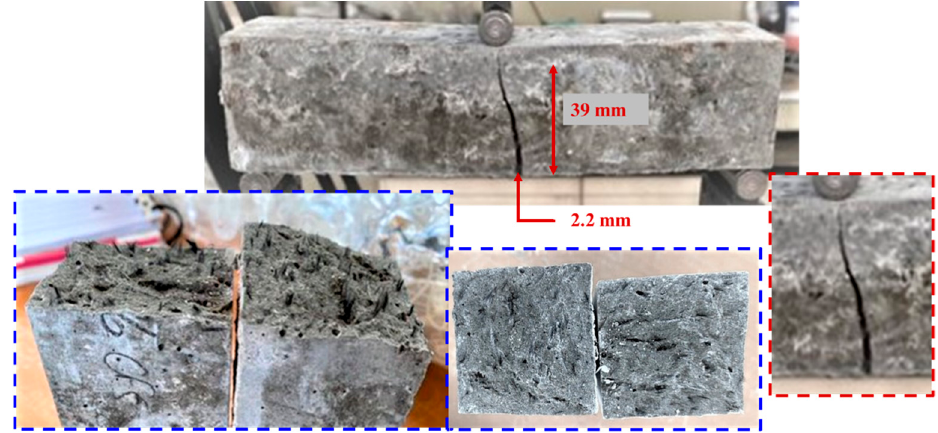
Figure 14. Crack width and length after bending test and CFs concentration at the rupture interface in the case of wet mixing of CFs adding CNC.